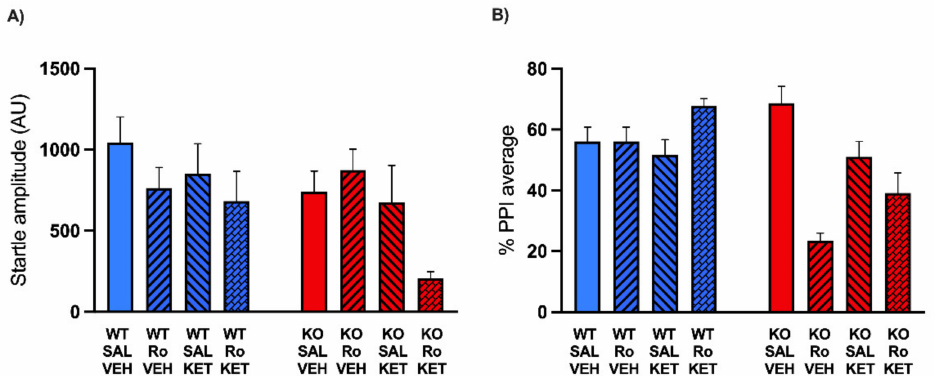
Figure 5. Effects of the medial prefrontal cortex (mPFC) infusion of ketanserin (KET, 0.05 µ g/side) on the changes in startle reflex ( A ) and prepulse inhibition ( B ) induced by Ro-256981 (5 mg/kg, IP) in MAOA KO mice. Data are shown as means ± SEM. Significance levels refer to the results of post hoc comparisons of three-way ANOVA analyses. Main effects are not indicated. (SAL, saline; VEH, vehicle; AU, arbitrary units); n = 6–7/group. For further details, see results